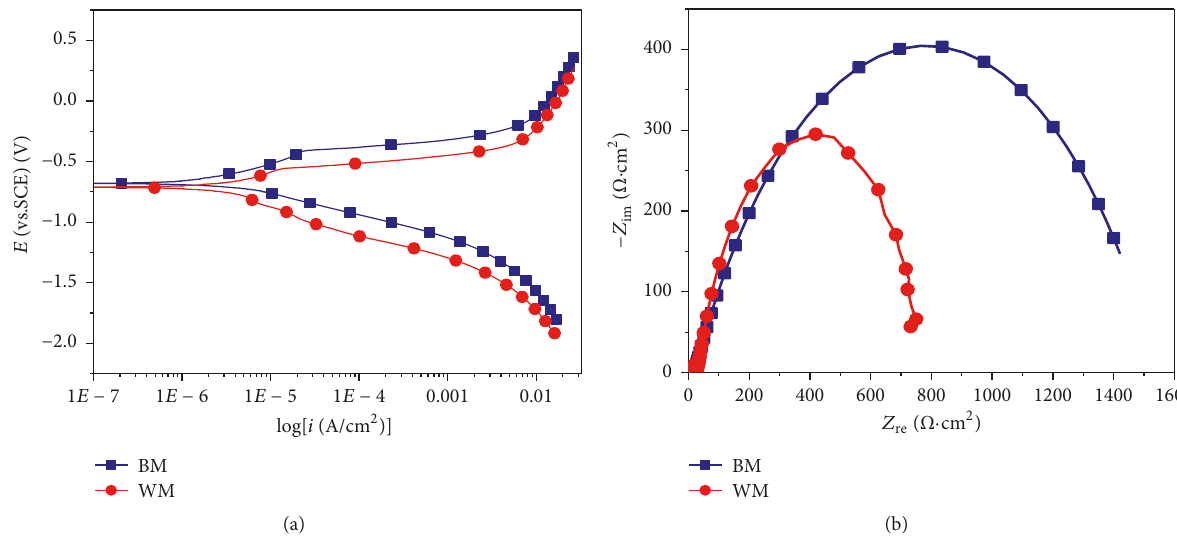
Figure 8: Results of electrochemical corrosion test of BM and WM in the Korla soil simulated solution. (a) Polarization curves and (b) EIS.